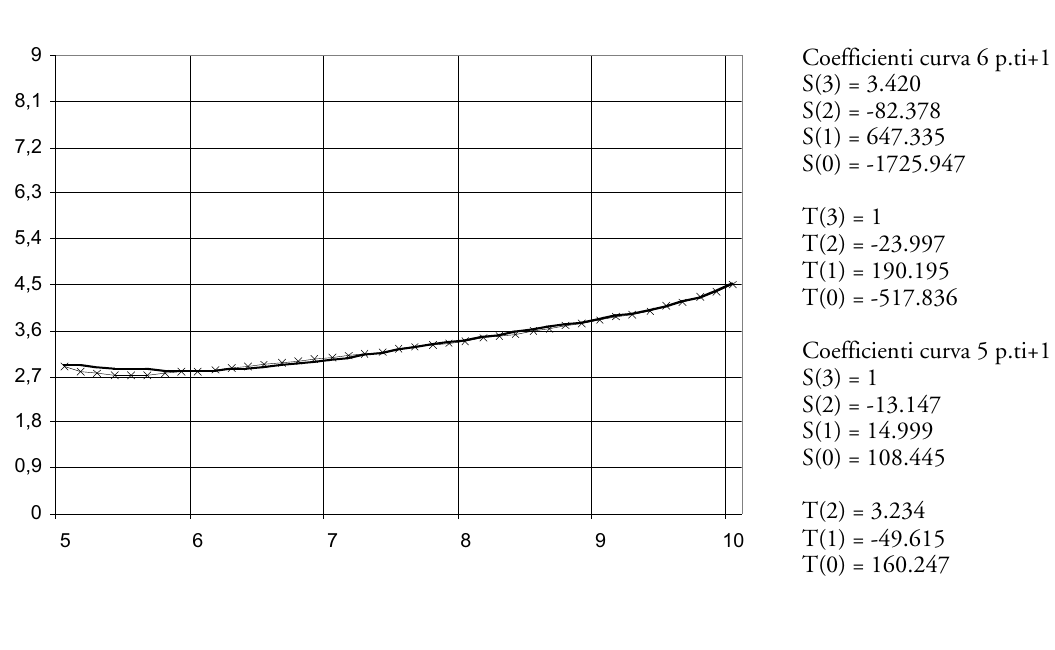
il 26-3-97 in MI Figura 4 – Rilevazione di CO 2 3 La curva a linea continua passa per i 6 punti e non presenta discontinuità, la curva a